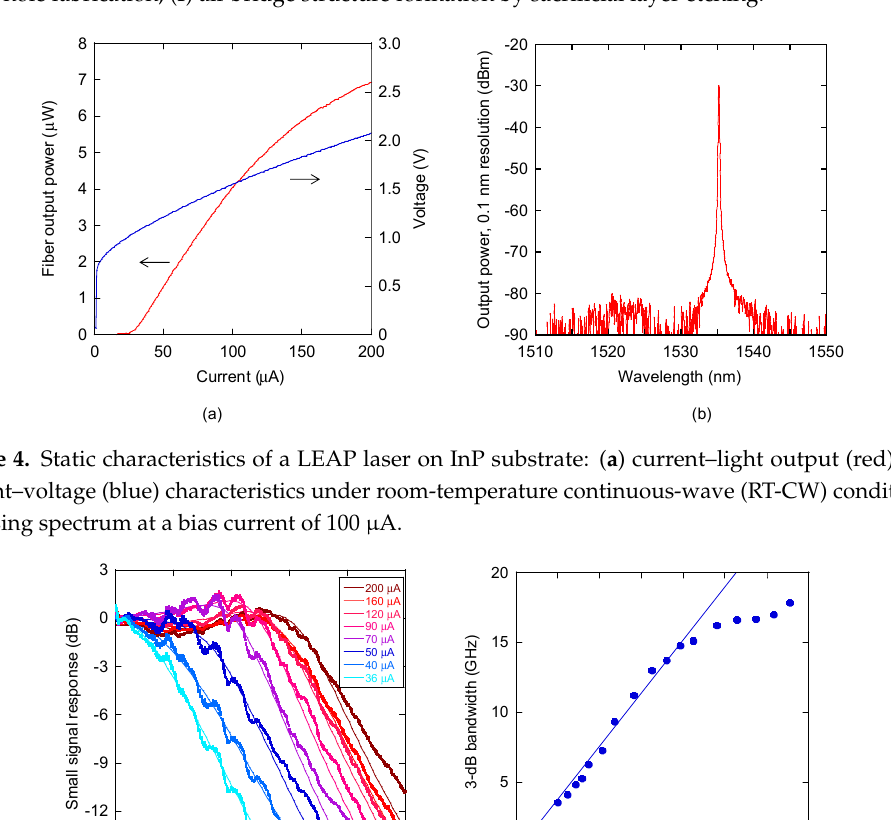
Figure 3. Fabrication of a LEAP laser: ( a ) Epitaxial growth of the active layer; ( b ) removal of multiple quantum wells (MQW), except for the active region; ( c ) buried regrowth; ( d ) p-and n-type doping; ( e ) air hole fabrication; ( f ) air bridge structure formation by sacrificial layer etching.